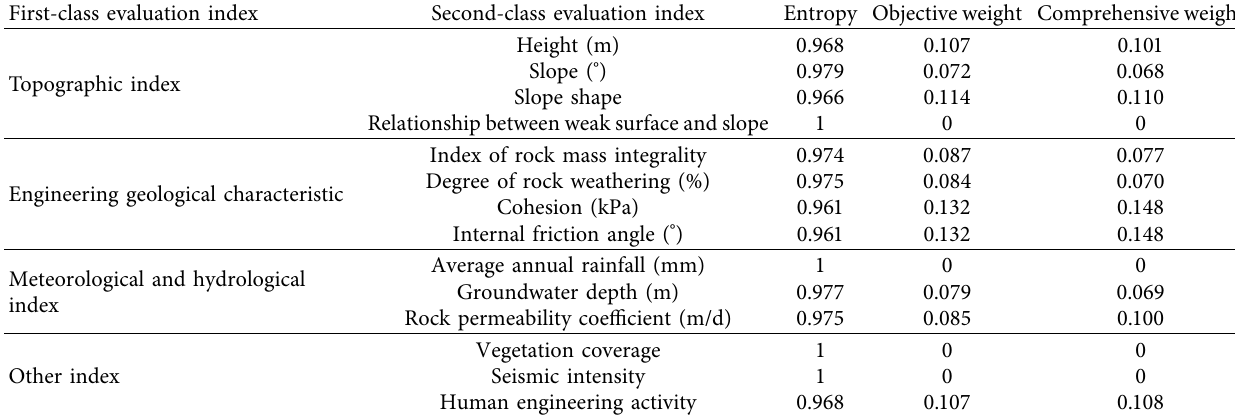
Table 5: Objective weight and comprehensive weight of evaluation index.